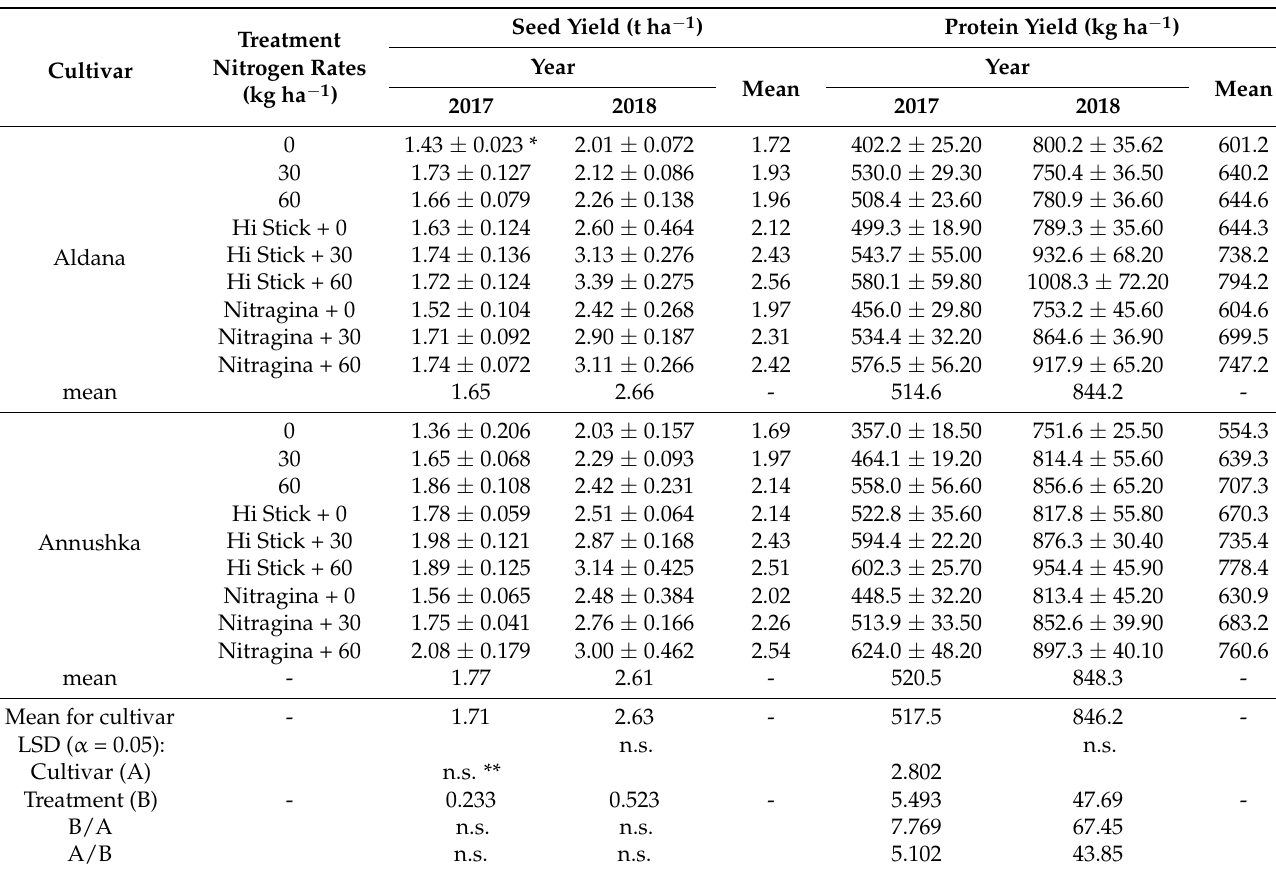
Table 1. Effect of mineral nitrogen fertilization and inoculation on seed and protein yields in two soybean cultivars in 2017 and